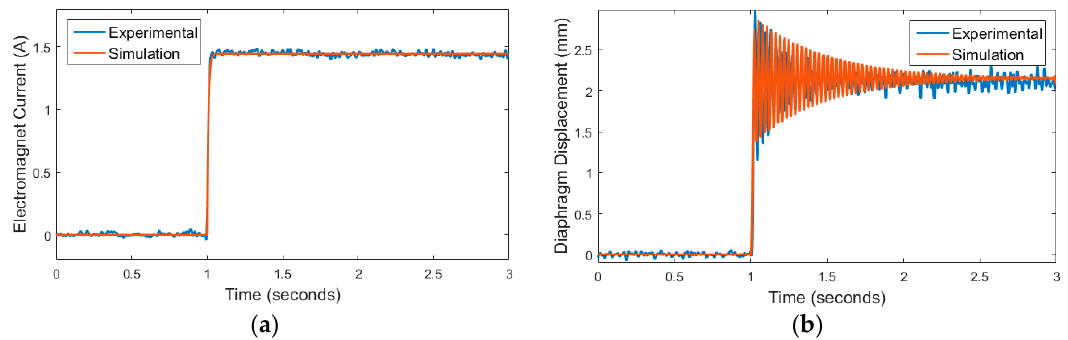
Figure 2. Optimisation Results: ( a ) T1 Current (RMS = 0.018 A); ( b ) T1 Displacement (RMS = 0.22 mm).